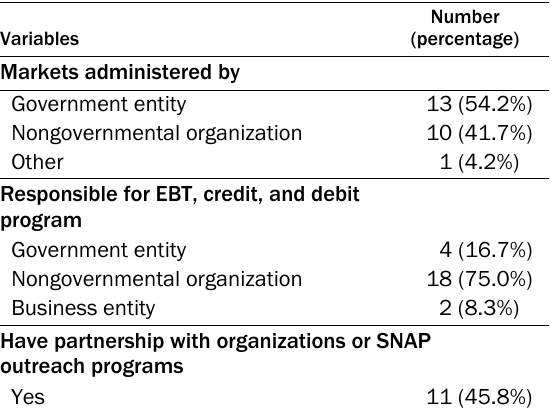
Table 1. Characteristics of Illinois